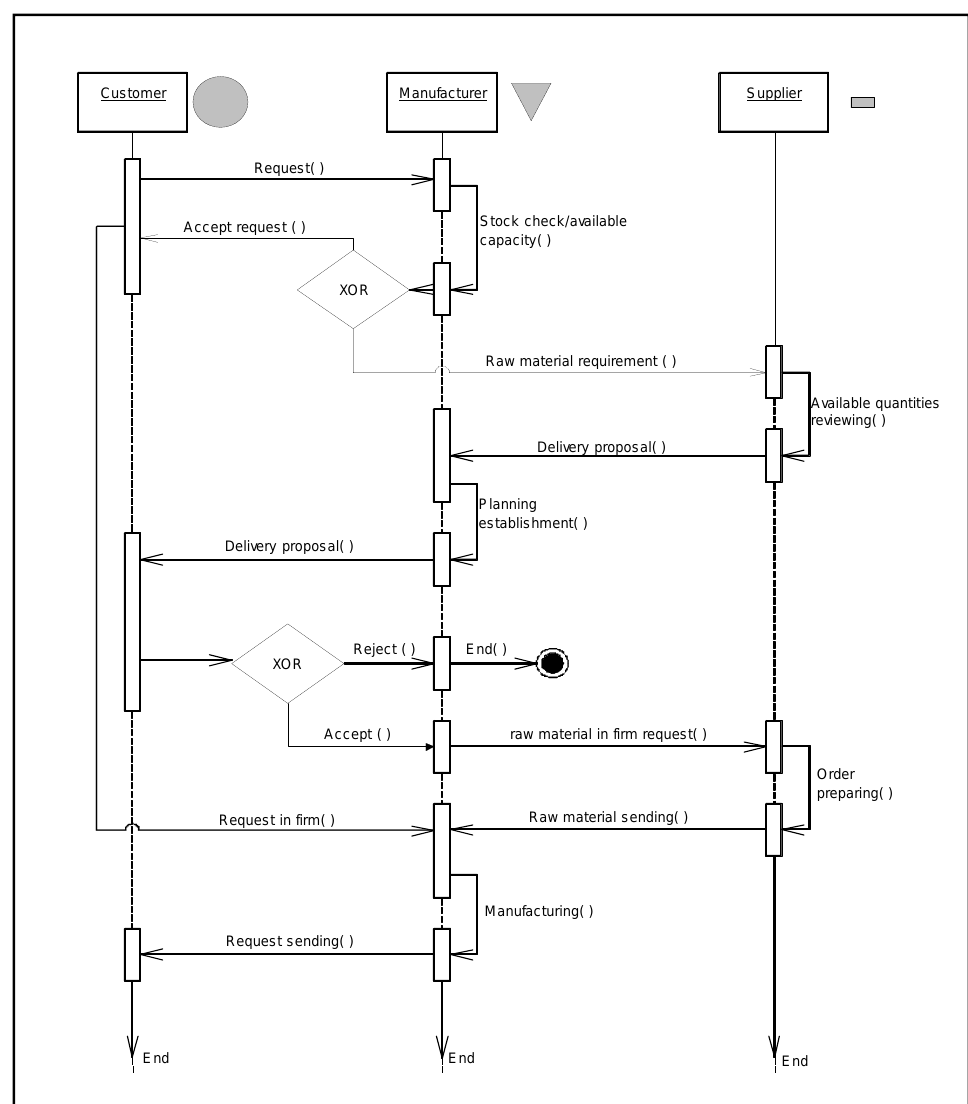
Figure 5. “UML sequence model for the supply